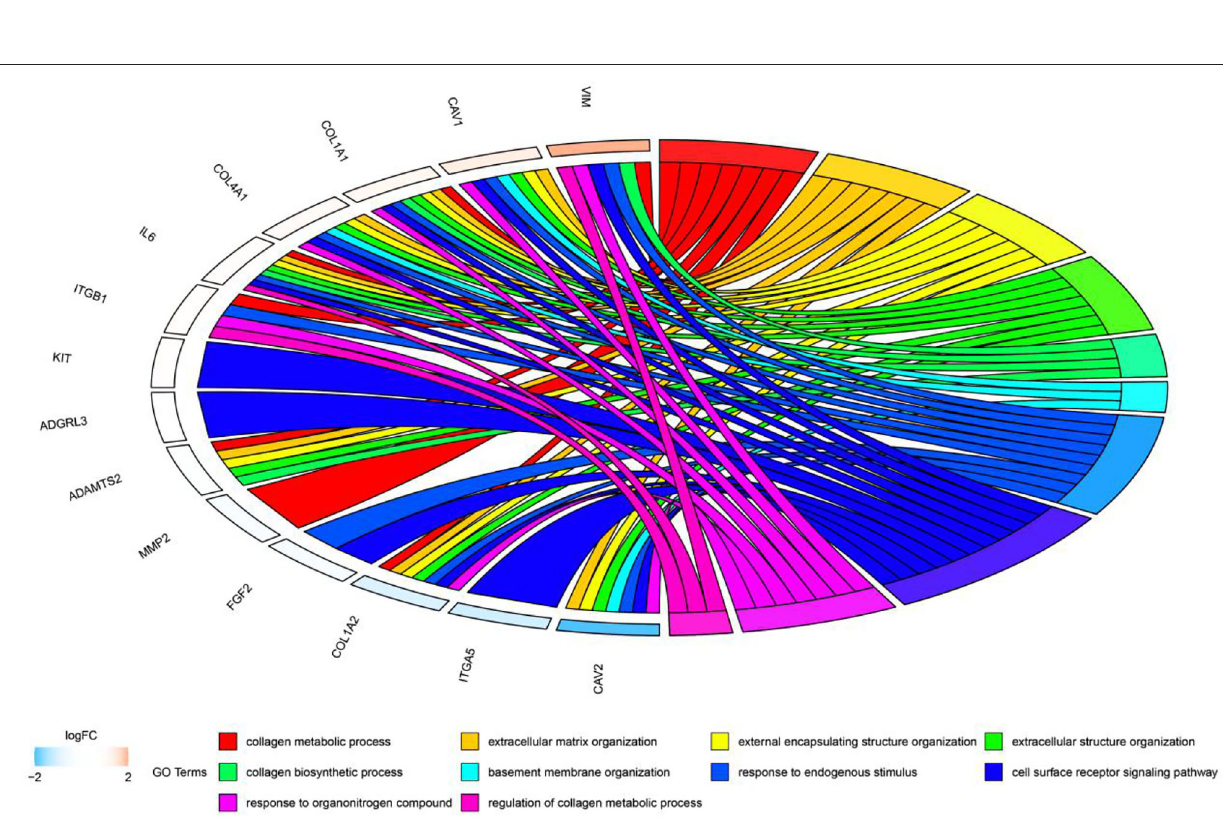
FIGURE 11 | Circos plot to indicate the relationship between hub genes and KEGG